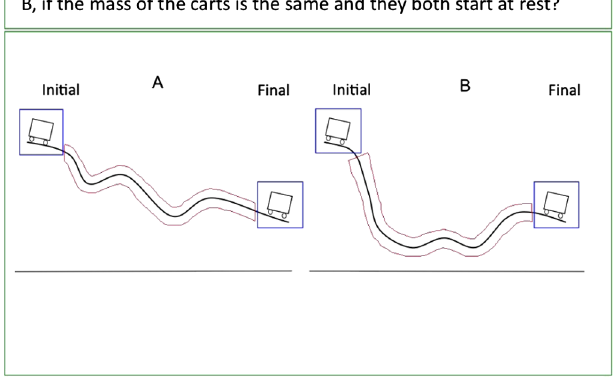
FIG. 9 (color online). Expertlike and novicelike definitions of areas of interest (AOI) for the roller coaster transfer problem. The expertlike AOIs are around the roller coaster carts (shown in blue) while the novicelike AOIs are around the tracks (shown in red). The green boxes outline the problem statement AOI and the diagram